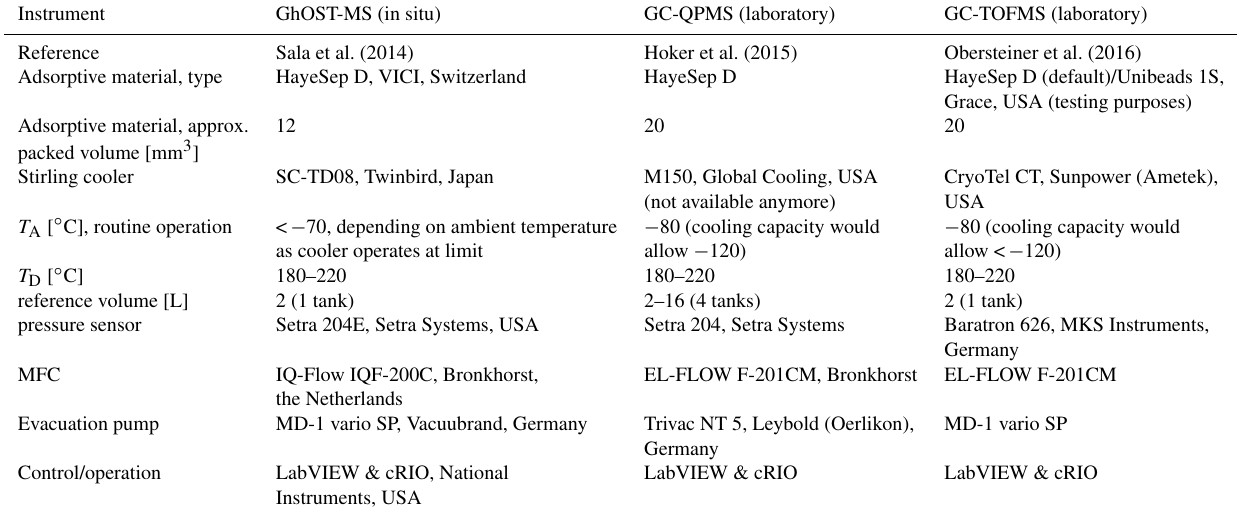
Table 1. Technical configuration of the three preconcentration set-ups. For further details on the full instruments (e.g. gas chromatography or detection), please refer to the respective references. T D is given as a temperature range as it can be determined only indirectly (see Sect. 2.3). Instrument